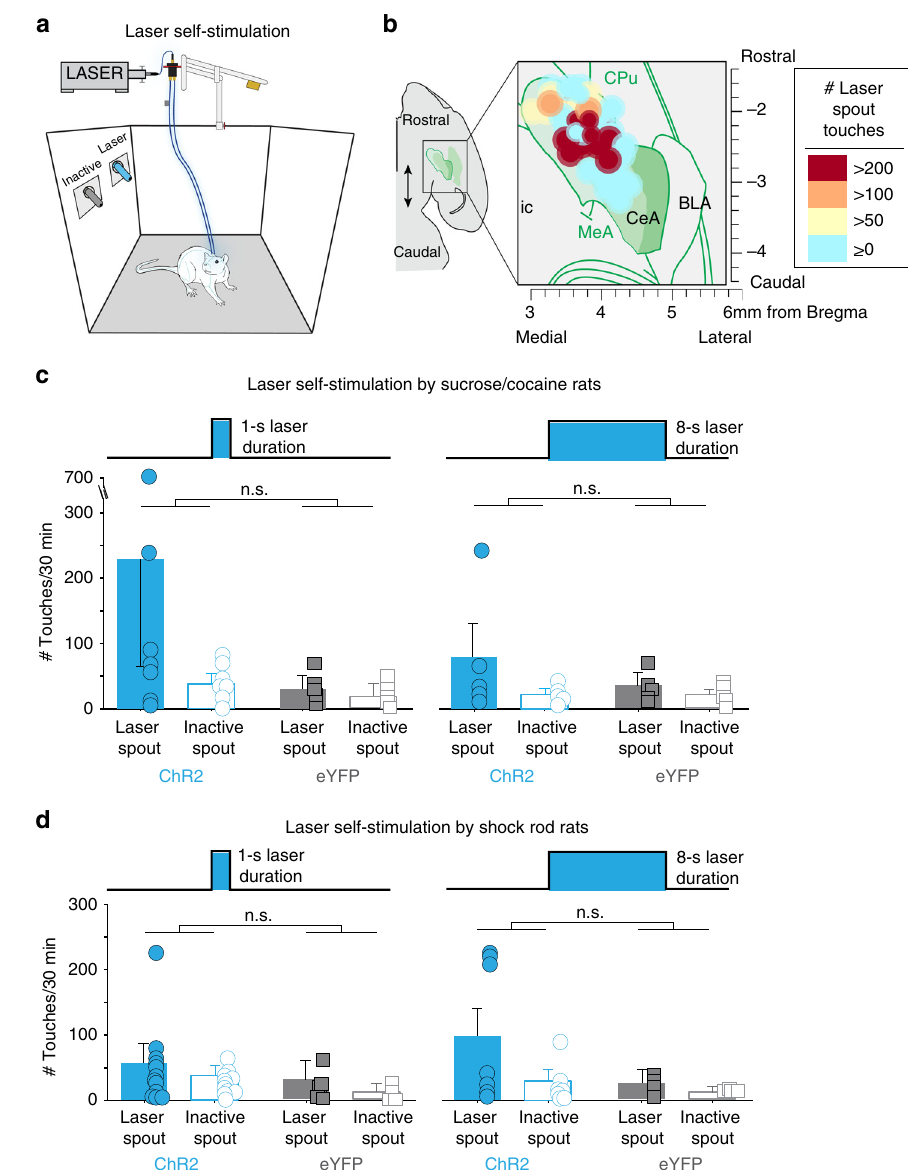
Fig. 7 CeA ChR2 stimulation is unreliable as reinforcer alone. a Laser self-administration task, in which touching a “ laser spout ” earned a laser stimulation (1-s or 8-s duration) and touching a separate “ Inactive spout ” earned nothing. b Placement map shows horizontal view of CeA optic fi ber placements (size determined be average Fos plume from Fig. 1) with color of each placement indicating an individual rat ’ s # of laser self-stimulations per 30-min test. c Total laser self-stimulations earned by rats from sucrose/cocaine experiments (ChR2 rats, N = 10 vs. eYFP rats, N = 5, 1 s laser duration, left: two-way ANOVA, virus × laser interaction: F 1,15 = 1.71, p = 0.21; 8 s laser duration, right: two-way ANOVA, virus × laser interaction: F 1,15 = 2.06, p = 0.18). d Total laser self- stimulations earned by rats from shock-rod experiments (ChR2 rats, N = 18, eYFP rats, N = 6, 1 s laser duration, left: two-way ANOVA, virus × laser interaction: F 1,18 = 0.07, p = 0.8; 8 s laser duration, right: two-way ANOVA, virus × laser interaction: F 1,18 = 1.93, p = 0.18). All data represent means and SEM; n.s., not signi fi